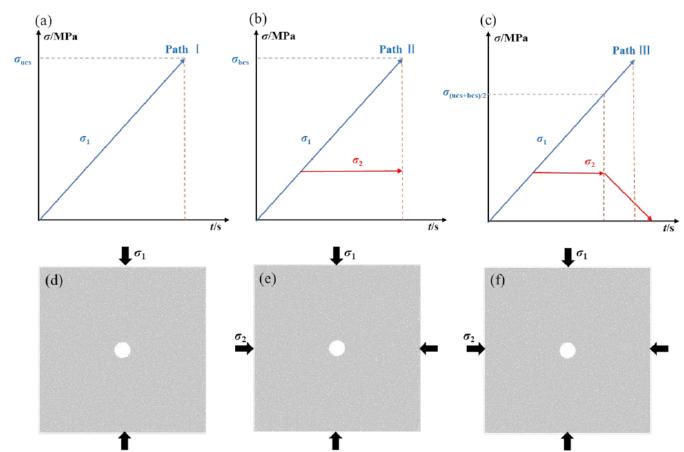
Figure 5. Stress paths and loading schematic diagrams in the numerical simulations, including stress paths under ( a ) uniaxial compression, ( b ) biaxial compression, and ( c ) coupled biaxial loading and unloading, and the loading schematic diagrams under ( d ) uniaxial compression, ( e ) biaxial compression, and ( f ) coupled biaxial loading and